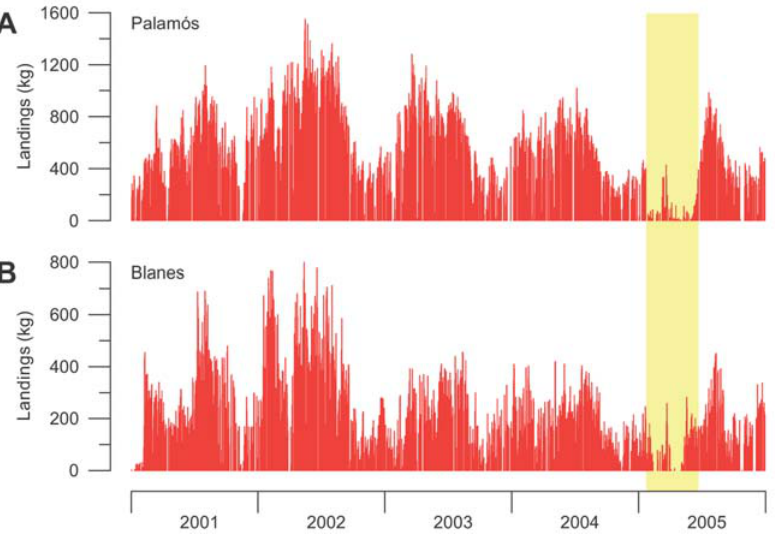
Figure 3. Intra-annual variability of daily catches. (A and B) Daily landings of Aristeus antennatus since 2001 at Palamo´s (A) and Blanes (B), the most representative studied harbors. Captures show a marked pattern of intra-annual variability with higher landings in spring-summer and lower landings in autumn, which has been attributed to reproductive displacements of the population [19]. The pale yellow band shows the period affected by the temporary fishery collapse caused by the winter 2005 dense shelf water cascading event, disrupting the intra-annual variability of precedent years.